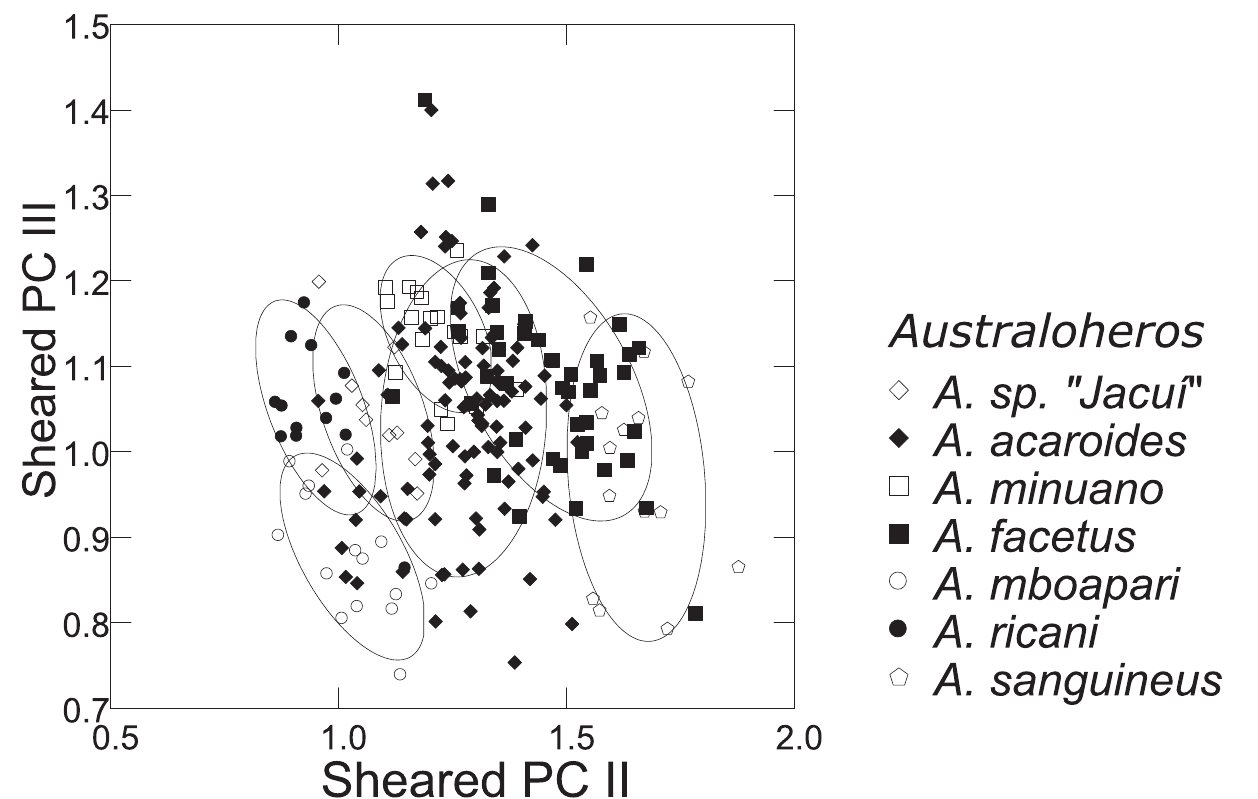
Fig 8. Plot of scores of PC III on PC II from PCA of 15 distance measurements from pooled southern coastal species of Australoheros ( A . acaroides , A . minuano , A . facetus , A . mbapoari , A . ricani , A . sanguineus ), and A . sp. “Jacuı´.”.